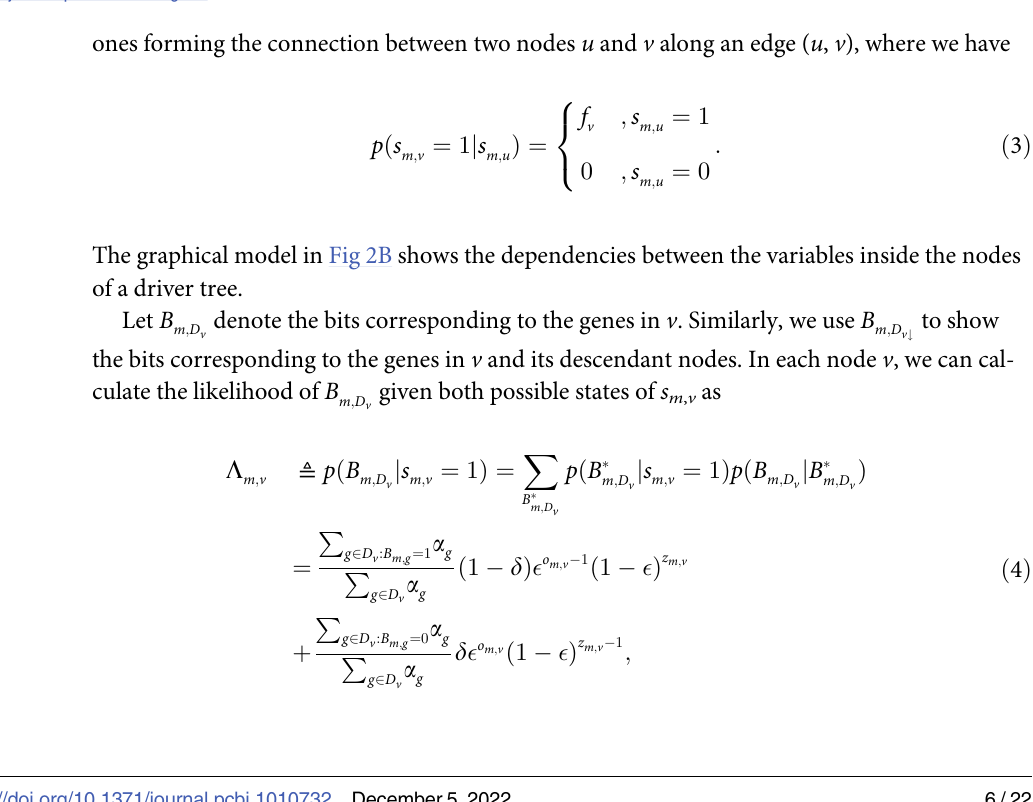
Fig 2. A . Graphical model of the generative process, where T is the progression model and � and δ are the probabilities of false positive and false negative, respectively. The latent and observed mutation matrices are denoted by B � and B , respectively. B . Graphical model of the variables in the nodes of the driver tree. The binary variable s is equal to one if and only if node u is mutated in tumor m . m , u